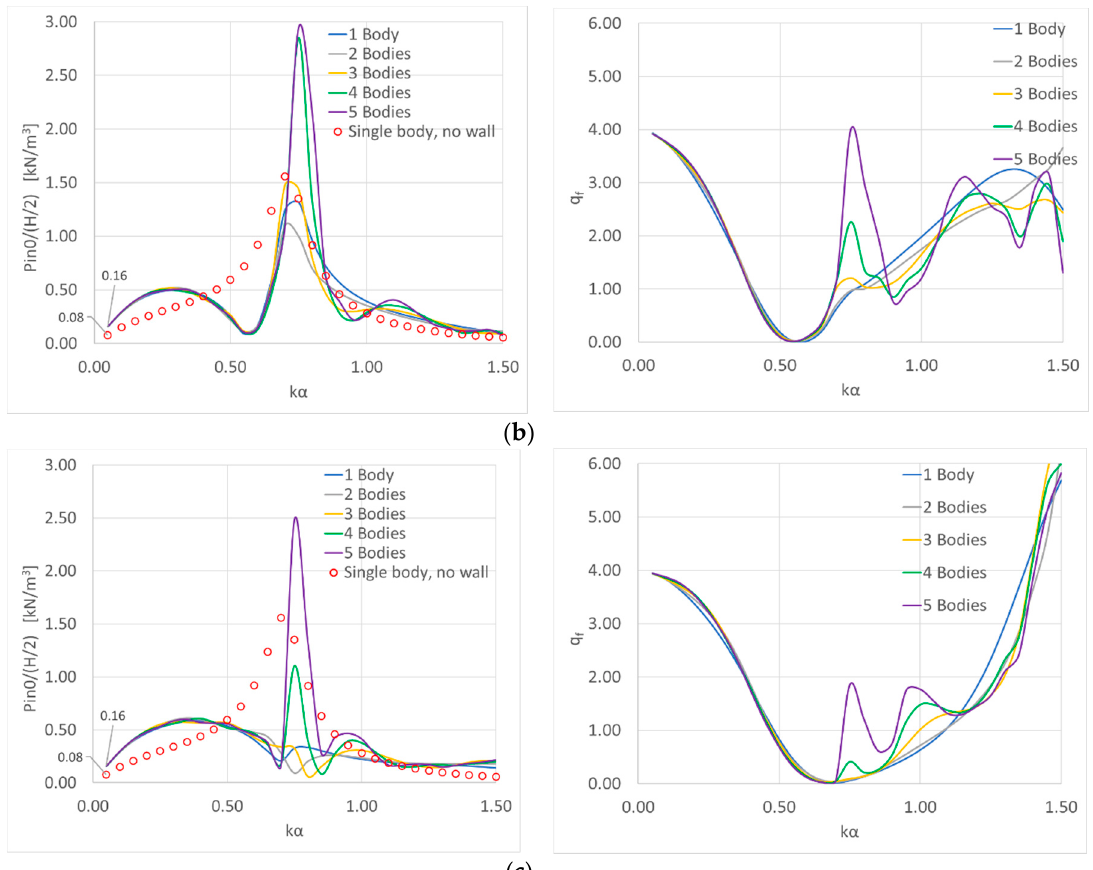
Figure 4. Air pressure inside the 1st OWC (left column figures) and array’s q f factor (right column figures) versus k α for various examined wave heading angles: ( a ) β = 0; ( b ) β = π /6; ( c ) β = π /4. Parallel arrangement.